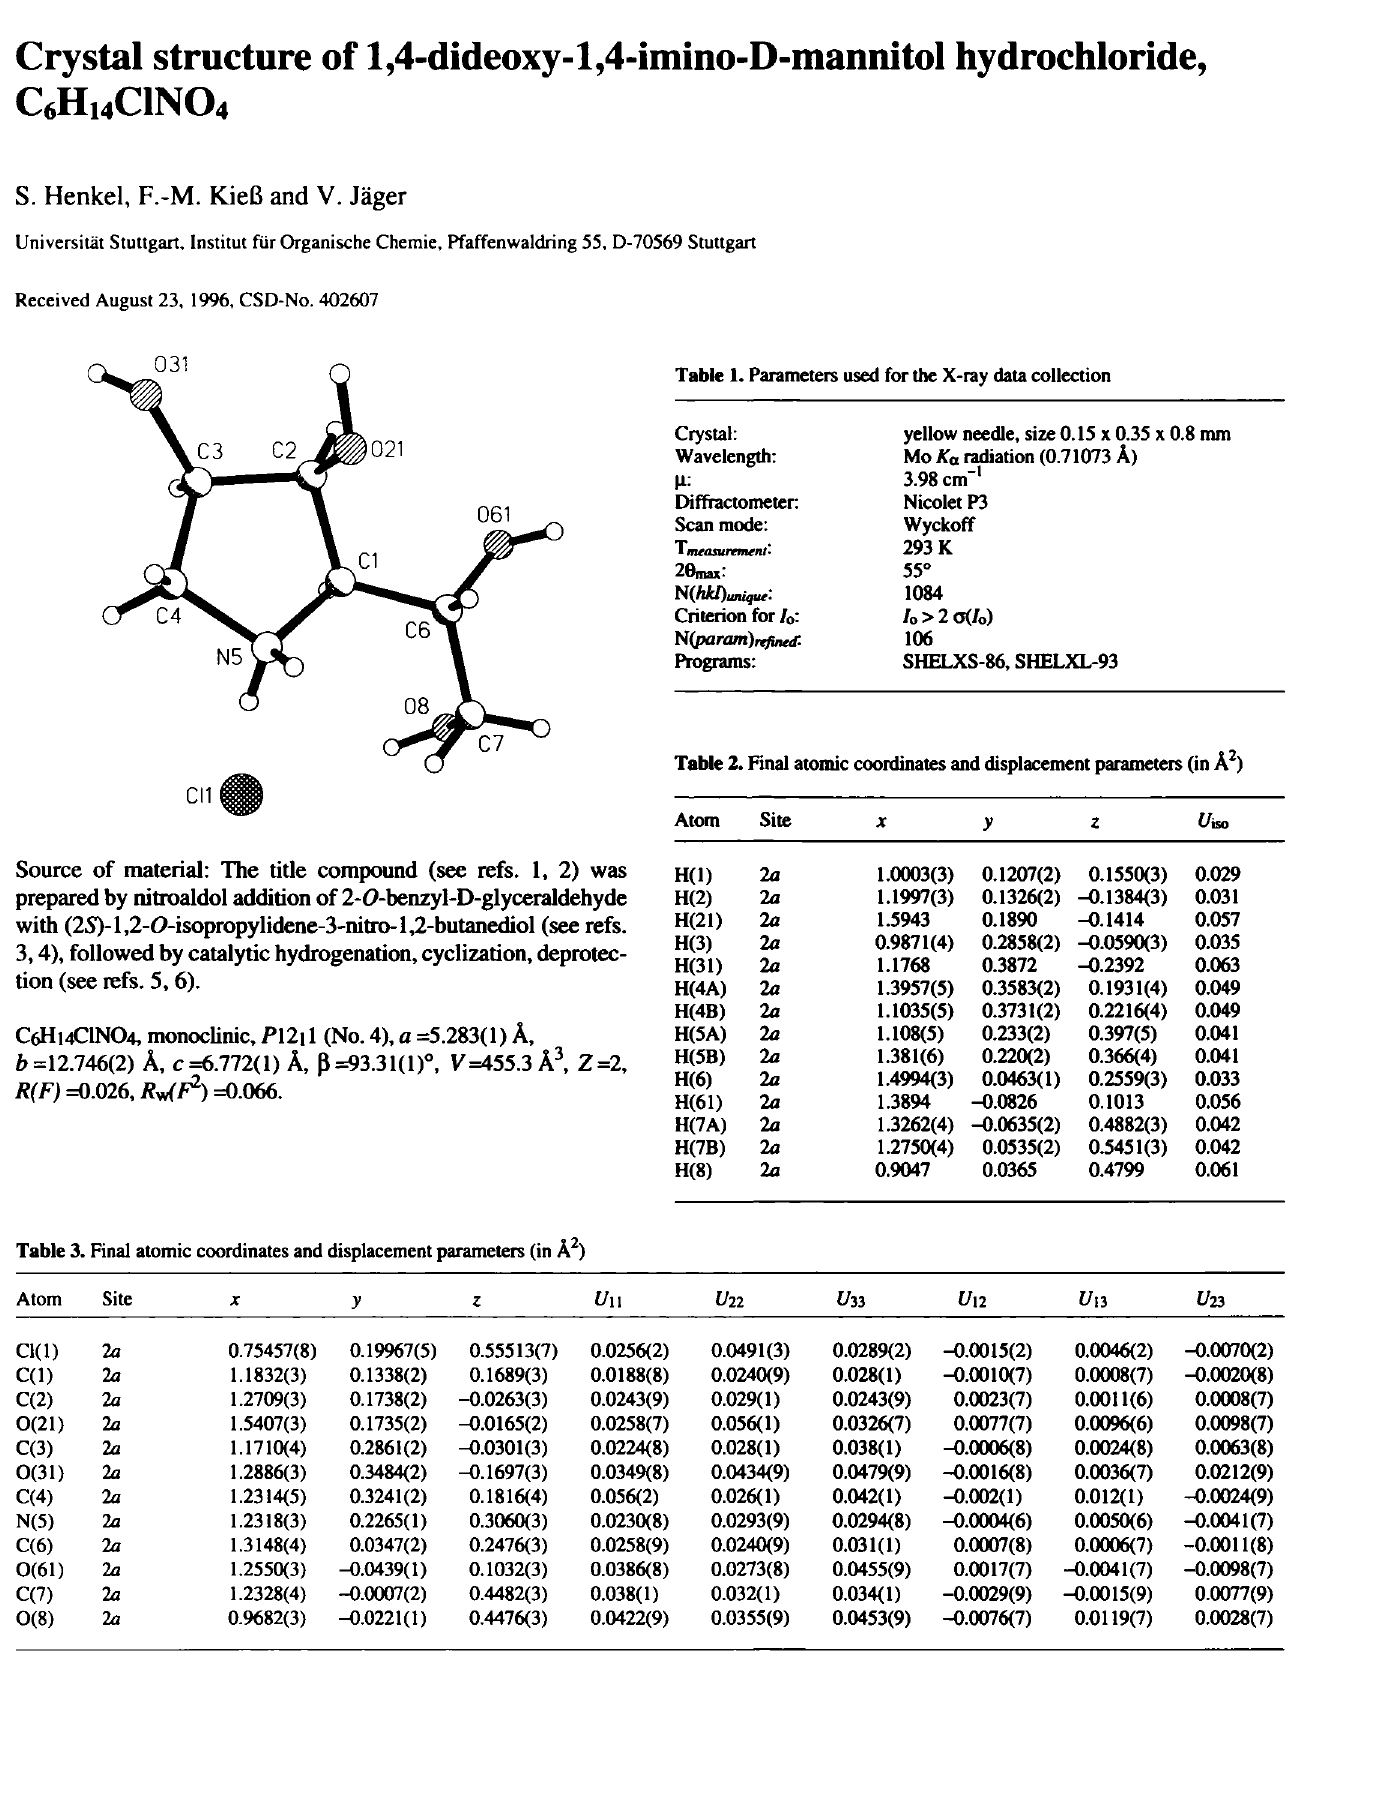
Table 3. Final atomic coordinates and displacement parameters (in Â 2 ) Atom